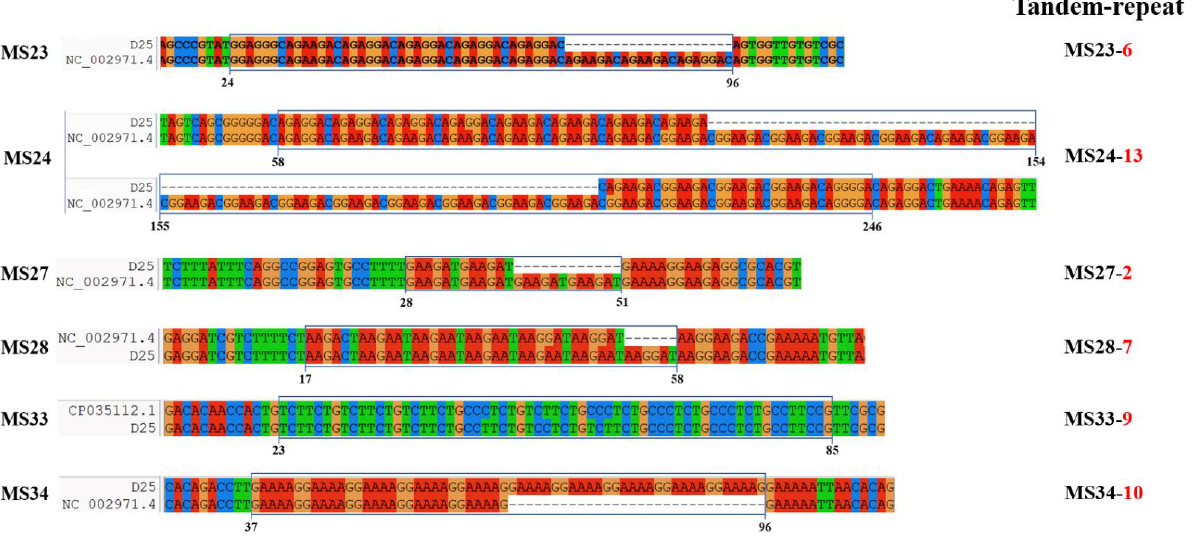
Figure 2. Identification of tandem repeat of C. burnetii . Alignment of sequences of six markers (MS23, MS24, MS27, MS28, MS33, and MS34) from the Nile Mile strain (NCBI accession No.: NC_002971 and CP035112) and the detected strain D25 is shown. The region with repeat units in each marker is indicated, and the numbers indicating the positions in the analyzed sequences are presented. Number of tandem repeats of each marker is